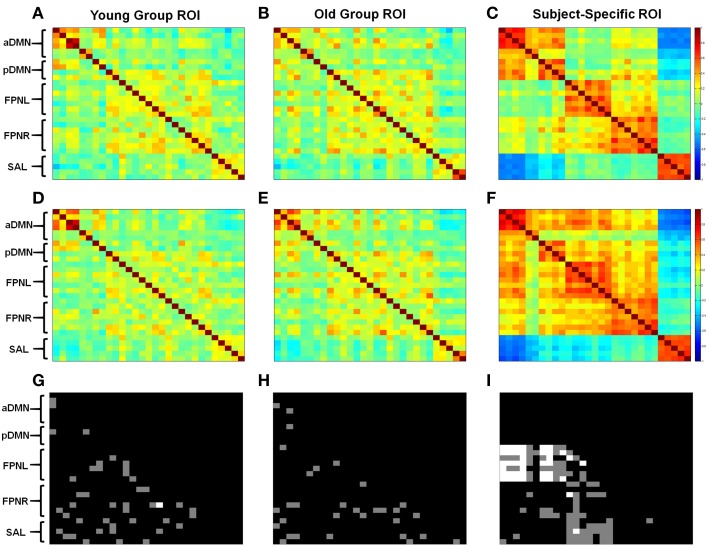
Different methods of ROI selection changes how changes in connectivity with aging are interpreted. Calculated correlation shows different changes in functional connectivity. Obtained correlation reveals different connectivity with young (A–C) and old (D–F) subjects. Statistical differences are shown between old and young subjects using young group ROIs (G), old group ROIs (H), and subjects-specific ROIs (I). Gray regions show statistical differences for p < 0.05 and white regions show statistical difference for pCorrected < 0.05. ROIs are listed from top to bottom for each network. aDMN: PCC, PFC, PLL, PLR, HCL, HCR. pDMN: PCC, PFC, PLL, PLR. FPNL: ACC, PCC, IPSL, IPSR, IFSL, IFSR, OTC. FPNR: ACC, PCC, IPSL, IPSR, IFSL, IFSR, OTC. SAL: ACC, PFCL, PFCR, IL, IR.